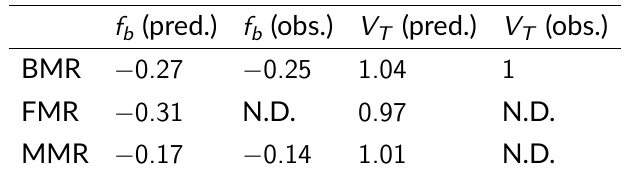
Table 3 – Predicted and observed exponents for the allometric scaling laws of breathing frequency f b and tidal volume V T at three different metabolic regimes (Altringham and Young, 1991; Haverkamp et al., 2005; GB West et al., 1997; Worthington et al., 1991), see equations